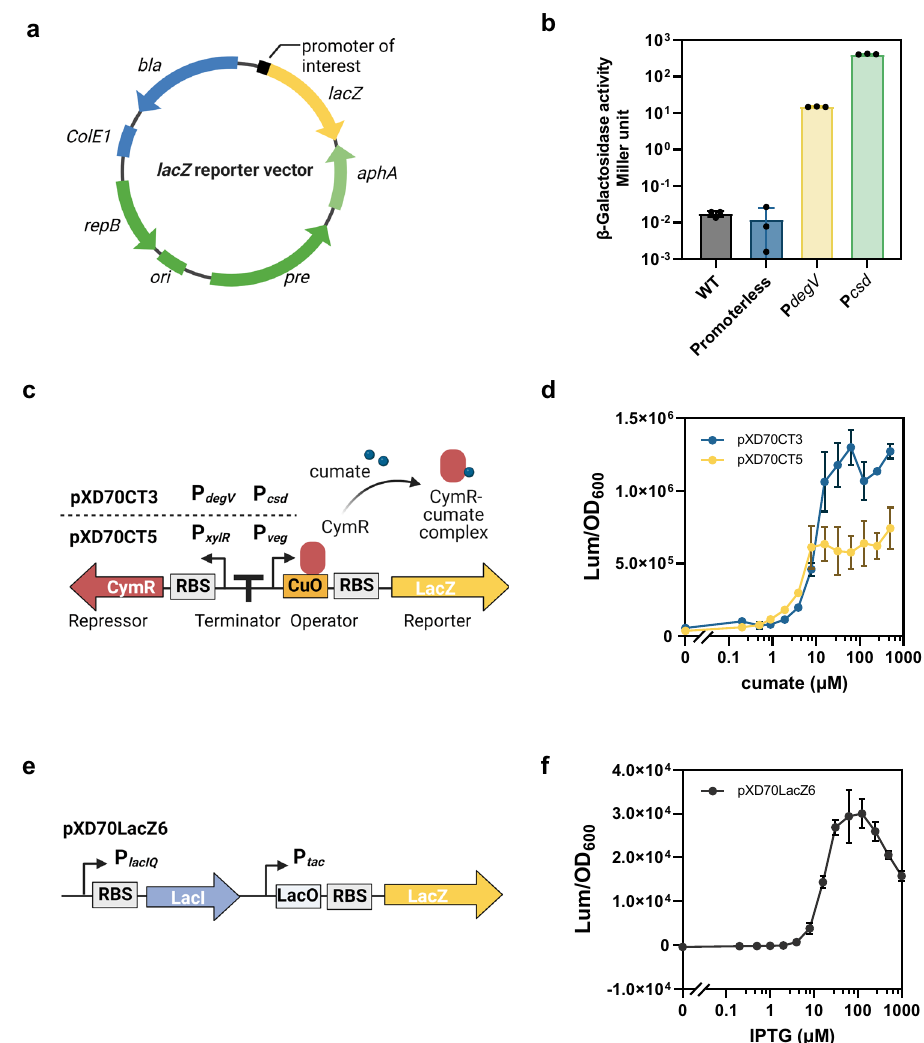
Fig. 2 | A lacZ reportersystemenables characterizationof E.lenta endogenous promoters and synthetic inducible expression systems. a E. coli lacZ is intro- ducedintopXD69m2vectorasareportergene in E.lenta . b LacZ assays revealed a high dynamic range for the lacZ reporter system in E. lenta . β -Gal activity was normalized to Miller units. c Design of cumate-inducible expression systems using the CymR repressor and CuO, expressed under the control of Bacillus and E. lenta